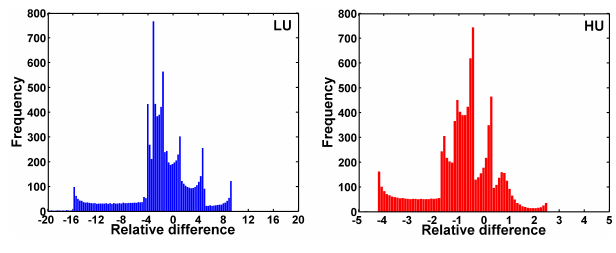
Figure 22. Histograms of the relative difference between (cid:49)Y and (cid:49)N CN dY under LU and HU conditions, where Y here denotes precip- dN CN = Y( 2 N CN ) − Y(N CN ) itation rate. (cid:49)Y , and dY is the derivative (cid:49)N CN dN CN 2 N CN − N CN of the precipitation rate along the variable N CN .